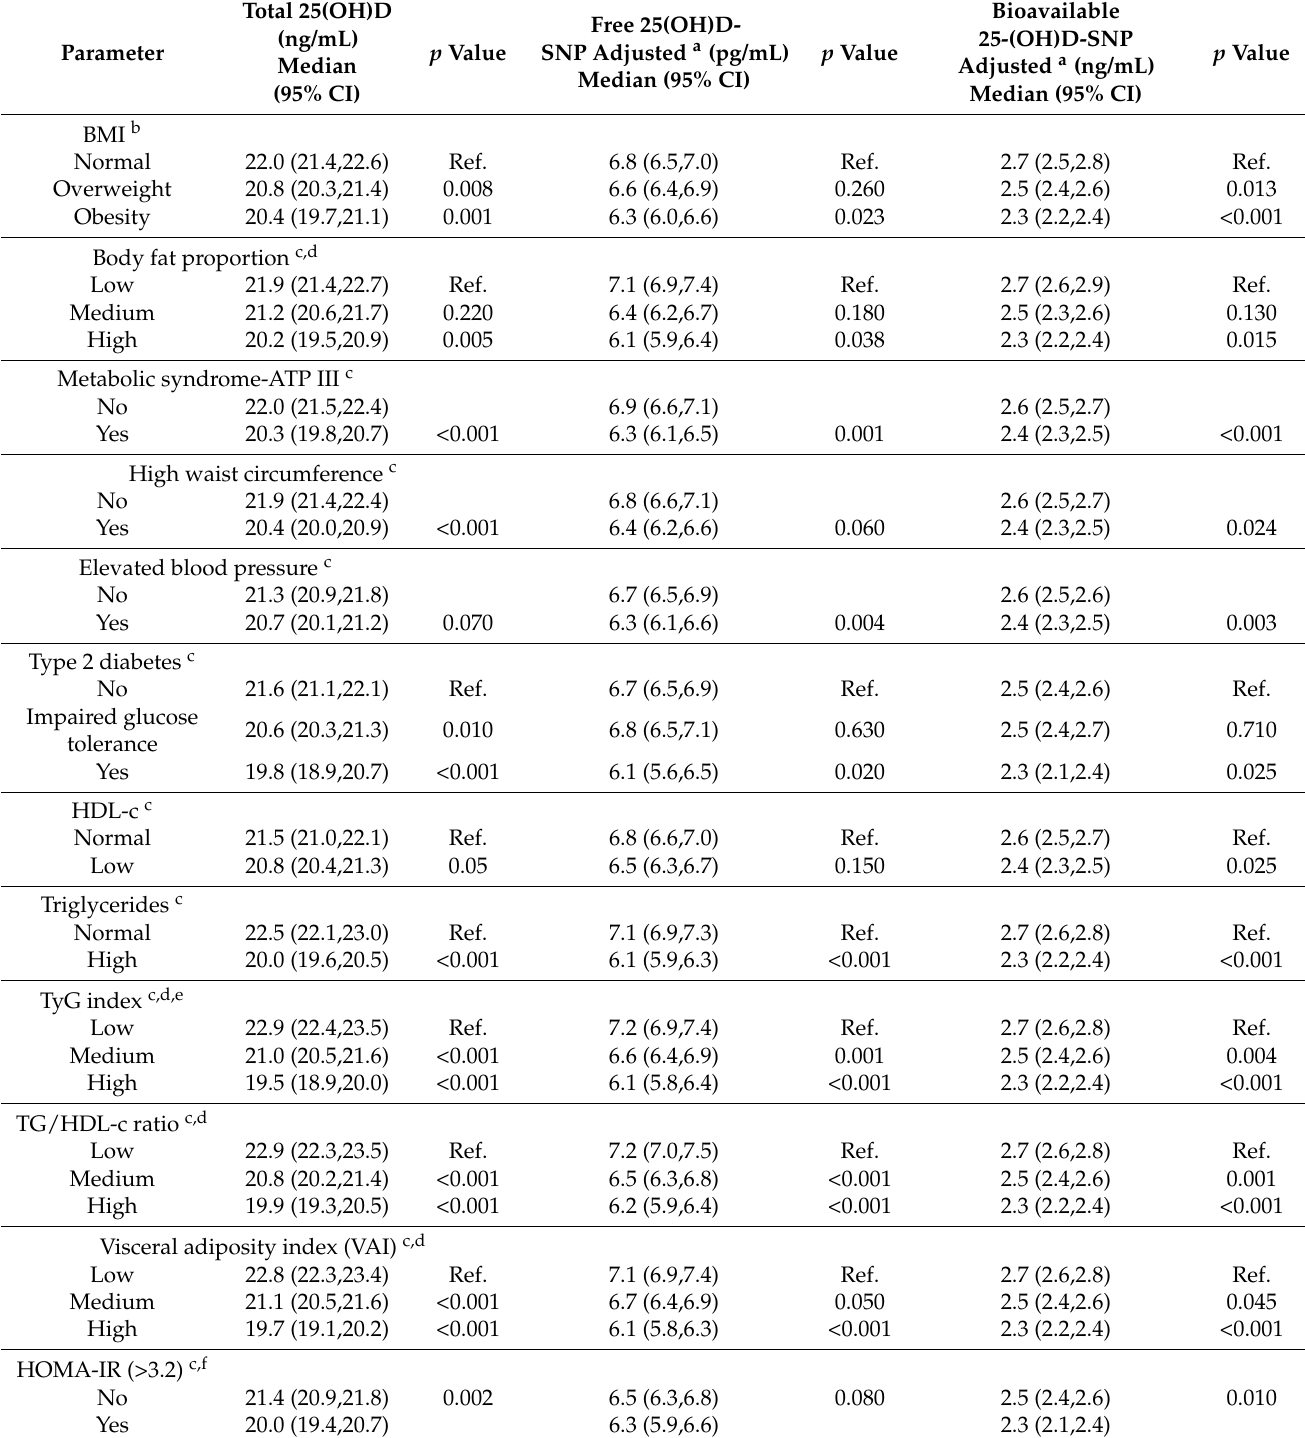
Table 2. Levels of total, free and bioavailable 25(OH)D by demographic and clinical characteristics from the Health Workers Cohort